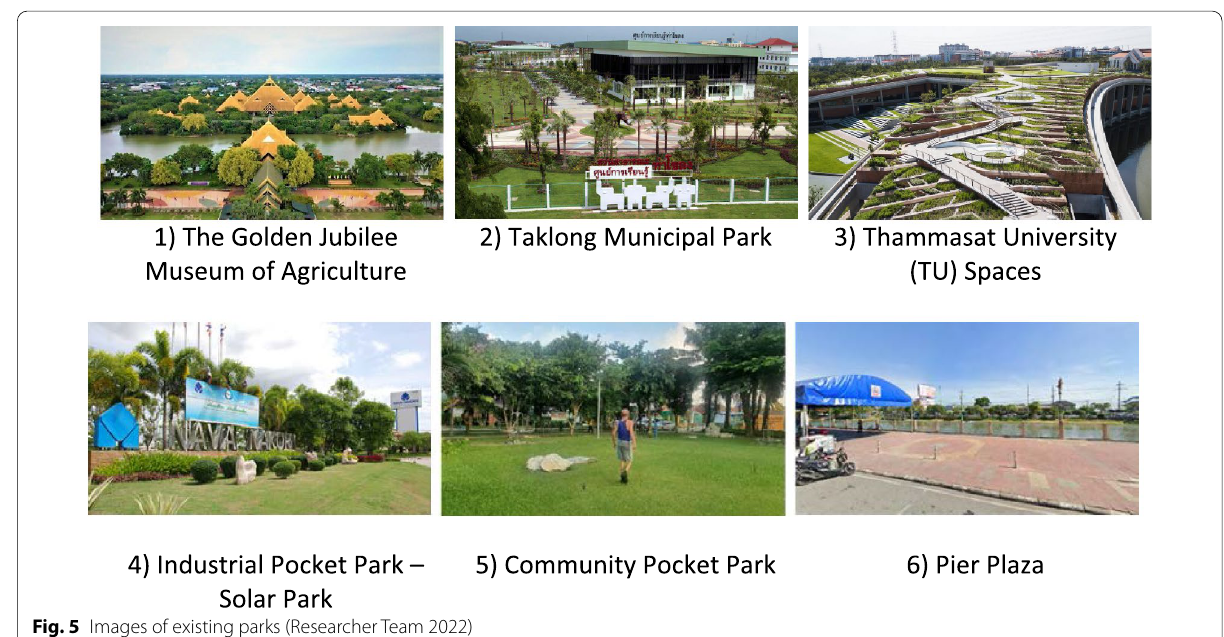
Fig. 5 Images of existing parks (Researcher Team 2022)